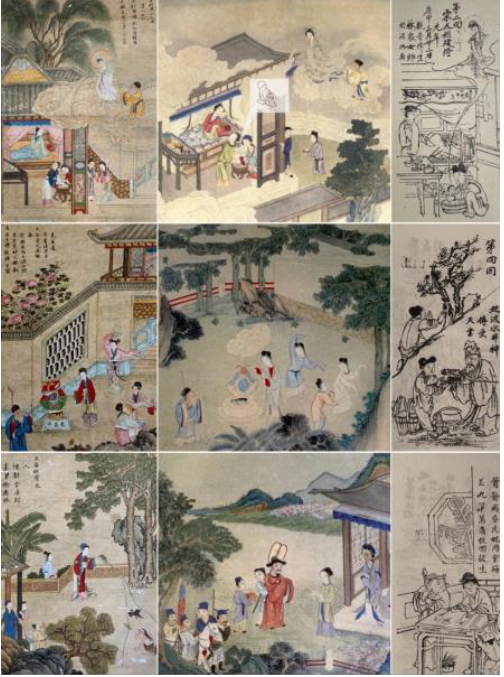
Figure 2. Xiangyou Fengtang Palace collection “ Scroll record of the Miracles Performed by the Celestial Empress ” , the National Museum of China Collection “ Pictorial Record of the Miracles Performed by the Holy Mother and Heavenly ” and the Republic of China rice paper lithograph wire bound book “ The Full Picture of the Treasure image of Lin Mazu ” . Source: Author ’ s photo- graph.